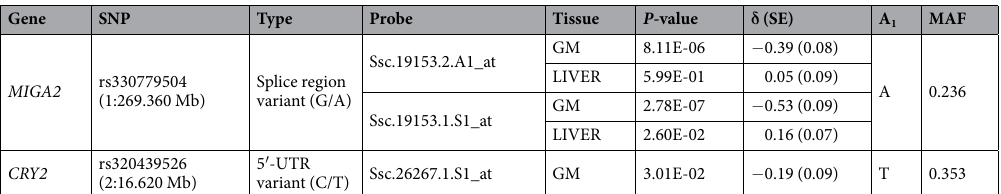
Table 3. Associations between MIGA2 and CRY2 genotypes and the mRNA levels of the corresponding genes estimated with microarrays in gluteus medius skeletal muscle and liver samples from Duroc pigs; δ : estimated allele substitution effect and standard error (SE); A 1 : minor allele, MAF: Minor allele frequency; GM: gluteus medius skeletal